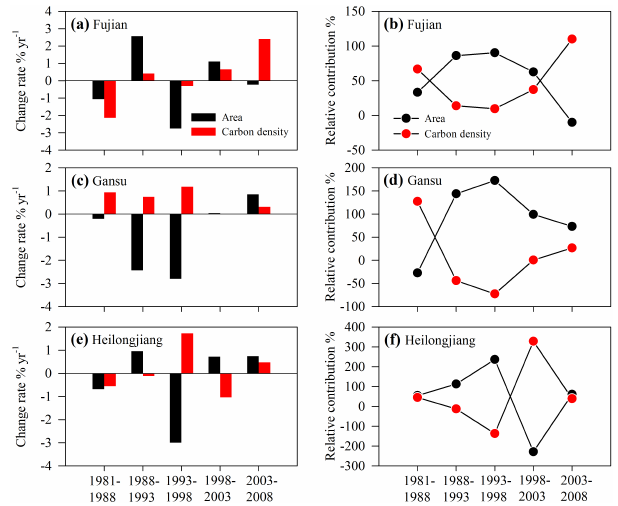
Figure 4. Rate of change ( a , c , and e ) and relative contributions of changes ( b , d , and f ) in forest area and carbon density of natu- ral forests to carbon loss in three provinces of China in the period 1977–2008. Bars and points represent the rates of change and the relative contributions of forest area (in black) and carbon density (in red),